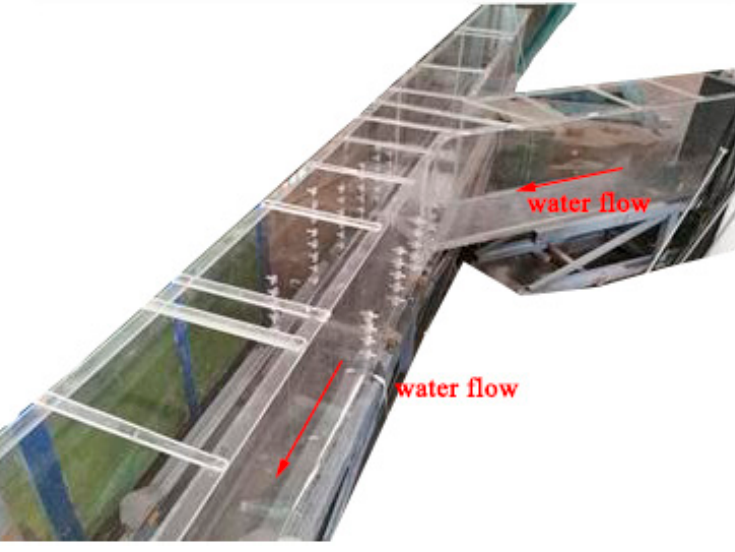
Figure 1. Photograph of the test apparatus.